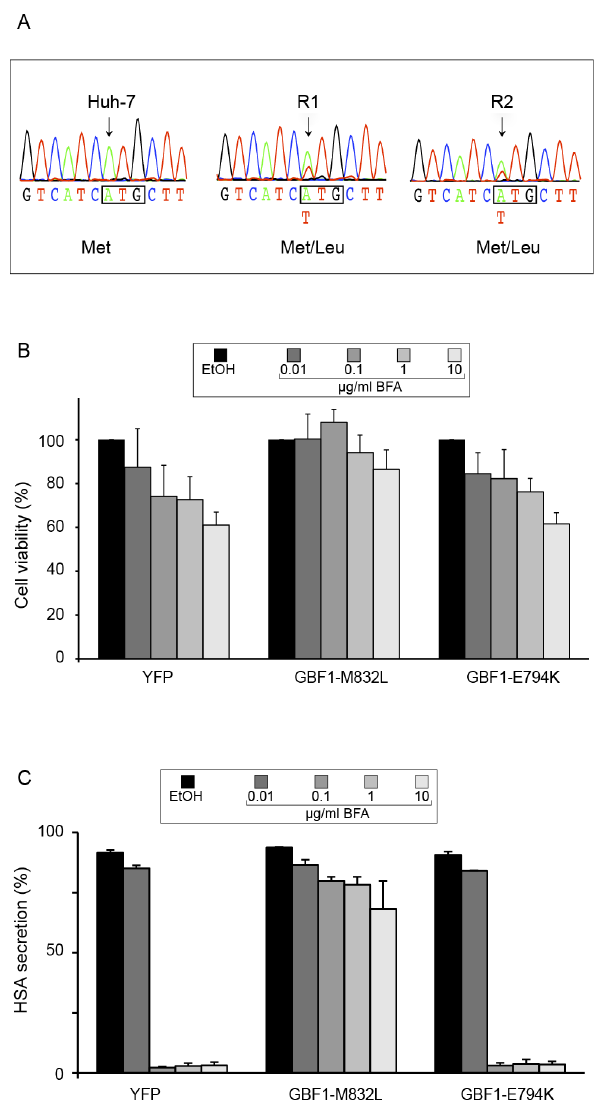
Figure 5. Mutation detected in GBF1 of R1 and R2 cells. (A) A fraction of the electrophoregrams corresponding to the sequence of GBF1 from the indicated cell lines is presented. The nucleotide and amino-acid sequences are indicated. The position of the mutation is indicated by an arrow. (B) Huh-7 cells were transfected with expression plasmids for GBF1-M832L, GBF1 inactive mutant E794K, or YFP.